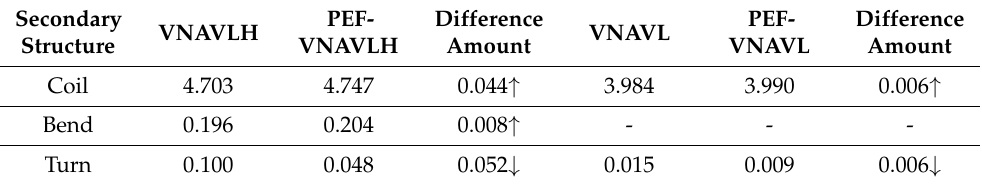
Figure 4. The DSSP graphic plots of ( A ) untreated VNAVLH, ( B ) PEF-treated VNAVLH, ( C ) untreated VNAVL, and ( D ) PEF-treated VNAVL, respectively. Table 2. The percentages of average secondary structure for peptides during the 300 nsec MD